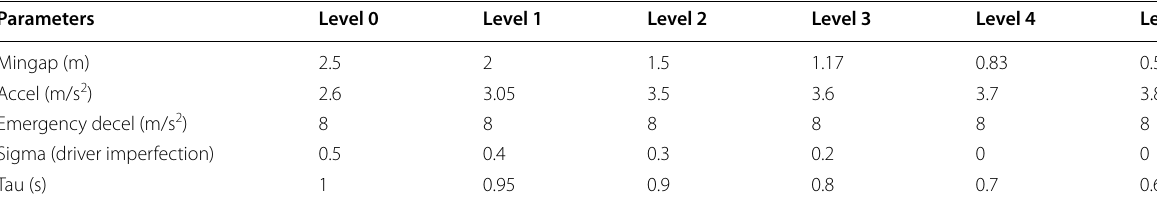
Table 1 The parameters for car following for varying levels of automation Parameters